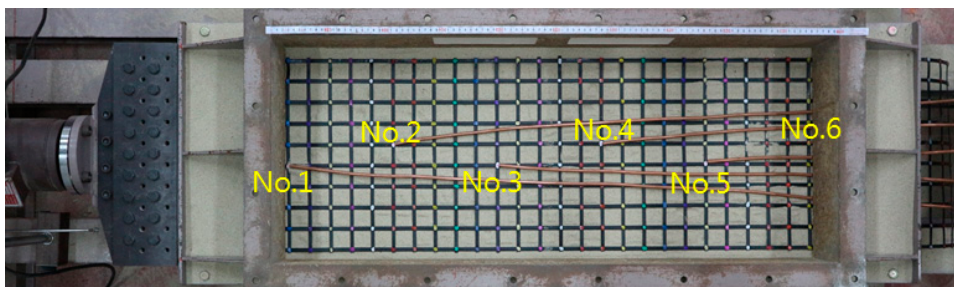
Figure 4. Points on the geogrid for measuring displacement in the pullout box.